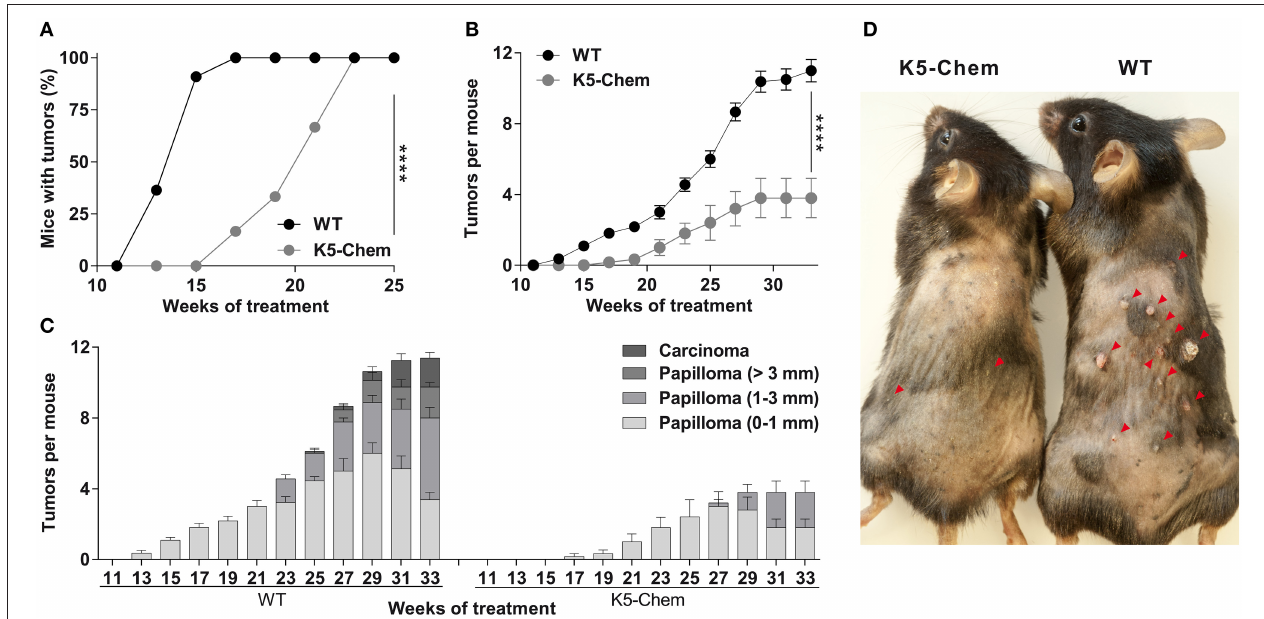
FIGURE 4 | Overexpression of bioactive chemerin in the skin delays tumor progression in a chemical carcinogenesis model. WT and K5-chemerin mice were subjected to the DMBA/TPA chemical carcinogenesis model. (A) Percentage of mice with tumors. The data are analyzed by Log-rank test. **** P < 0.0001. (B,C) Number of tumors per mouse ( B , mean ± SEM) and proportion of tumors according to size and stage was recorded every other week ( C, mean ± SEM). The data are analyzed by Mann-Withney test. The difference in tumor number between wild-type and K5-chemerin mice became significant from week 15 ( P < 0.001 and P < 0.0001 at week 33). (D) Representative WT and K5-chemerin mice at week 30 of the DMBA/TPA protocol. Red arrowheads indicate the location of papillomas. The displayed data result from the compilation of three independent experiments with five mice per group in each